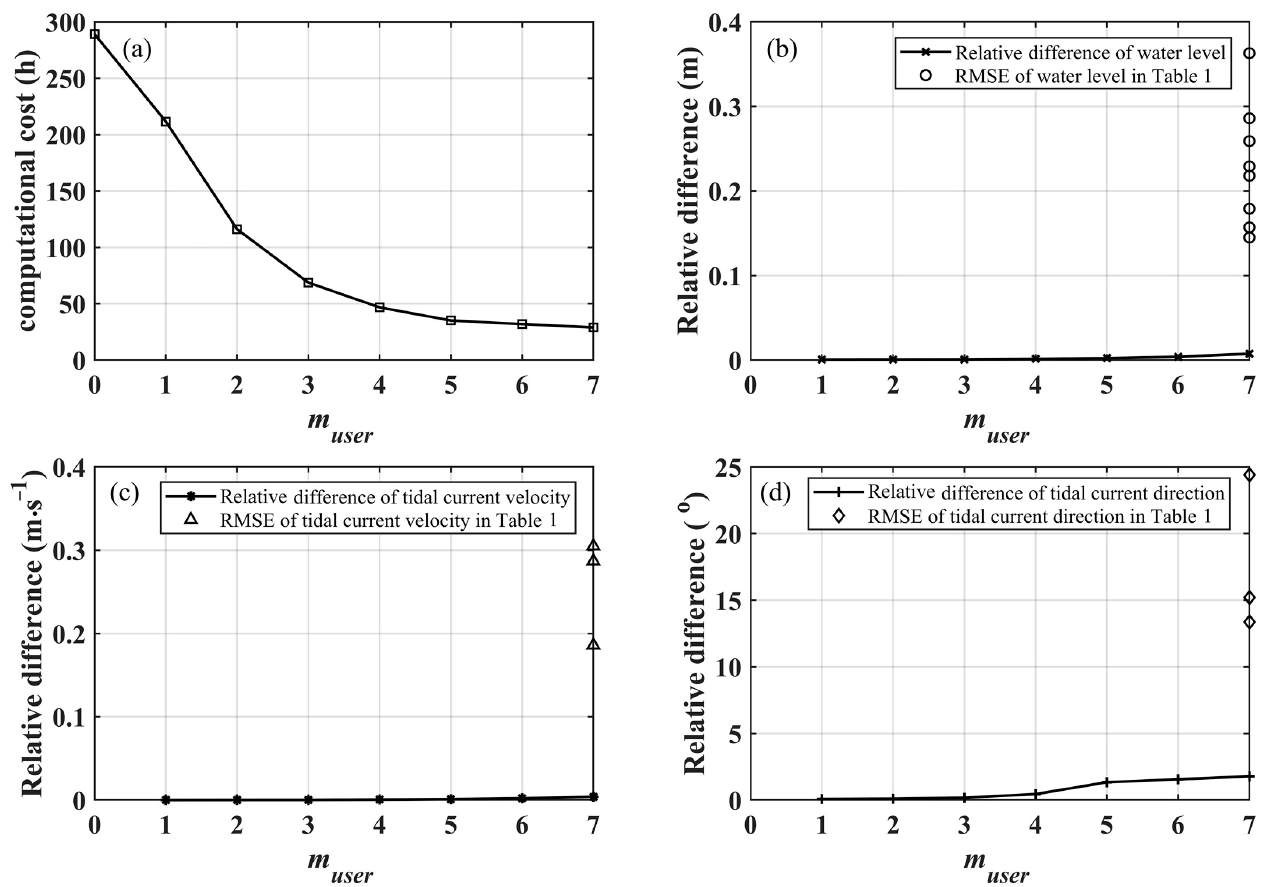
Figure 12. ( a ) Calculation efficiency varies with m user ; ( b ) the relative difference of tide level varies with m user ; ( c ) the relative difference of the tidal current velocity changes with m user ; ( d ) the relative difference of the tidal current direction changes with m user .